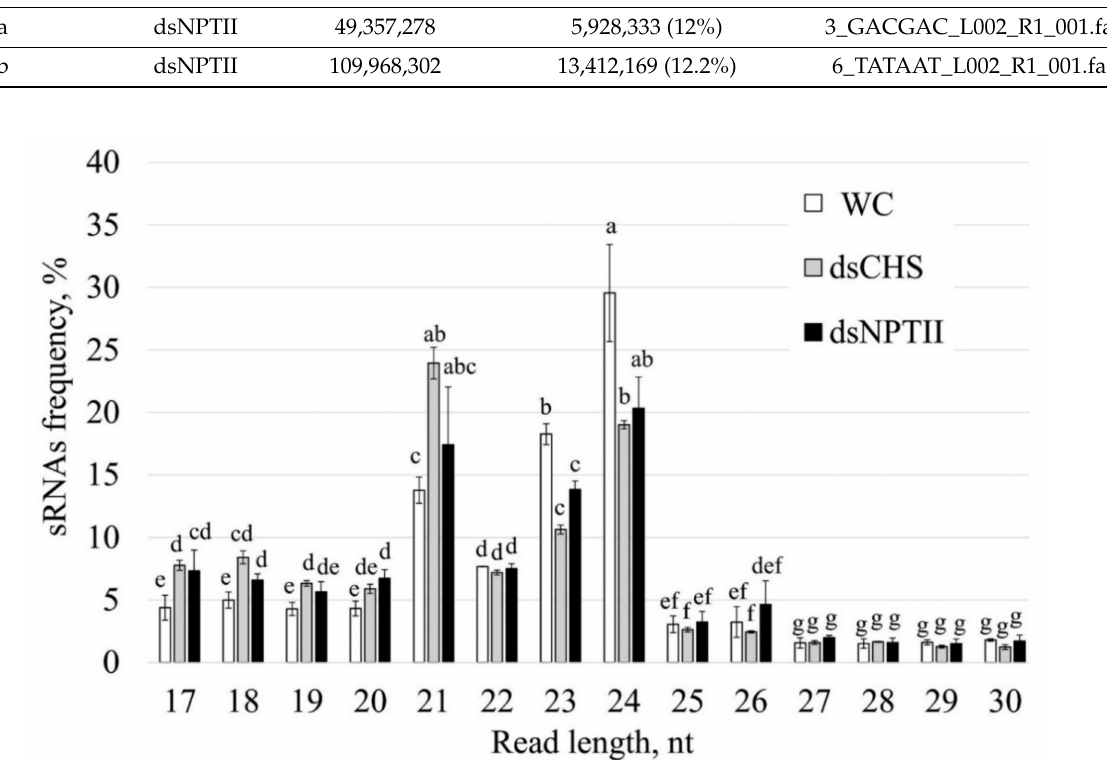
Figure 3. Length size distribution of total small RNAs in Arabidopsis thaliana after treatment with water or dsRNA. WC— A. thaliana plants treated with sterile water; dsCHS— A. thaliana treated with AtCHS -dsRNA; dsNPTII— A. thaliana treated with NPTII -dsRNA. The data are presented as the mean ± SE. Means followed by the same letter were not different using Student’s t -test. p < 0.05 was considered statistically